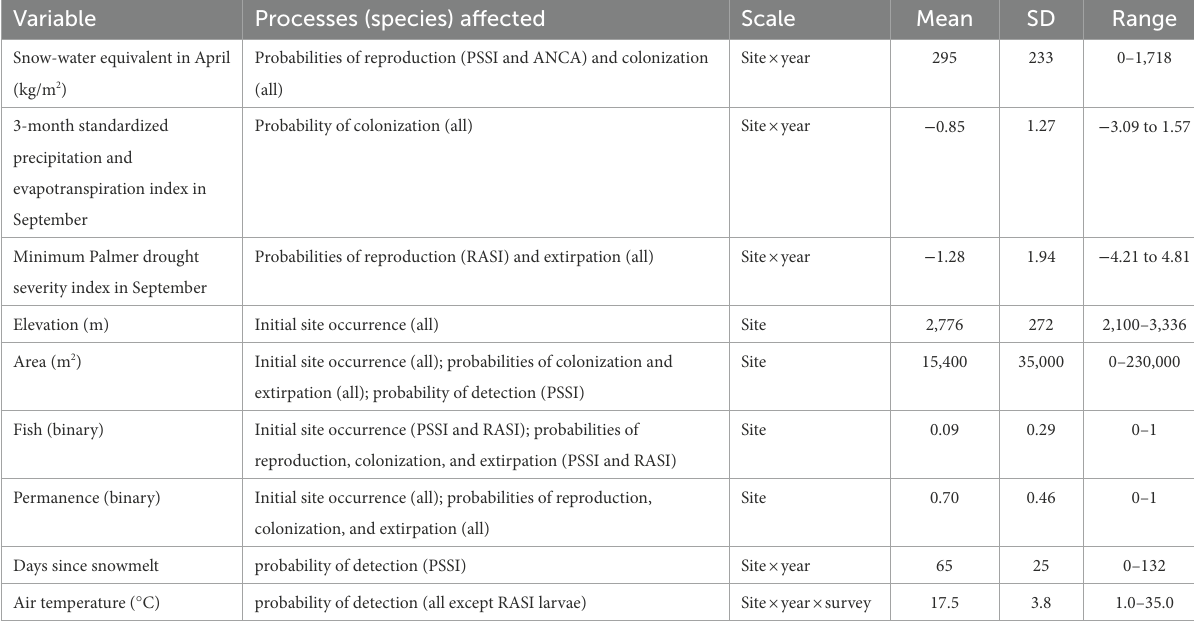
TABLE 1 Processes affected by and summaries of predictor variables included in the multi-scale multi-state models of amphibian occurrence and reproduction.